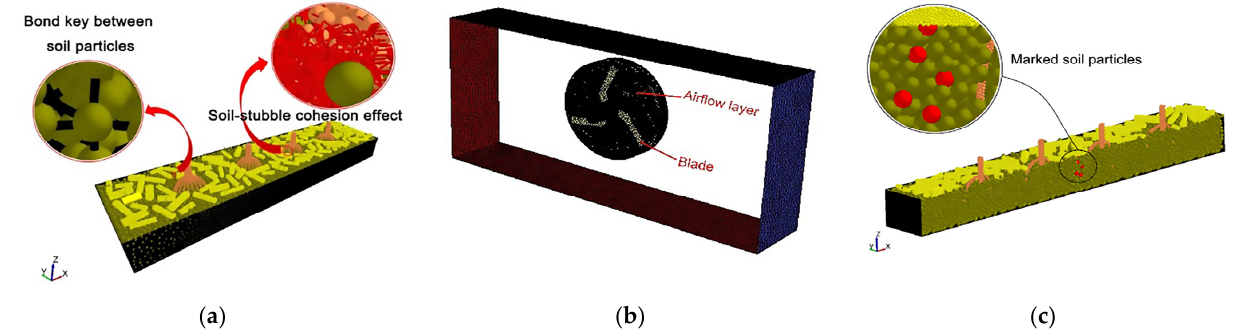
Figure 4. DEM-CFD coupling model: ( a ) soil, straw, and stubble model; ( b ) flow field model; ( c ) layout of marked soil particles single rental mark.